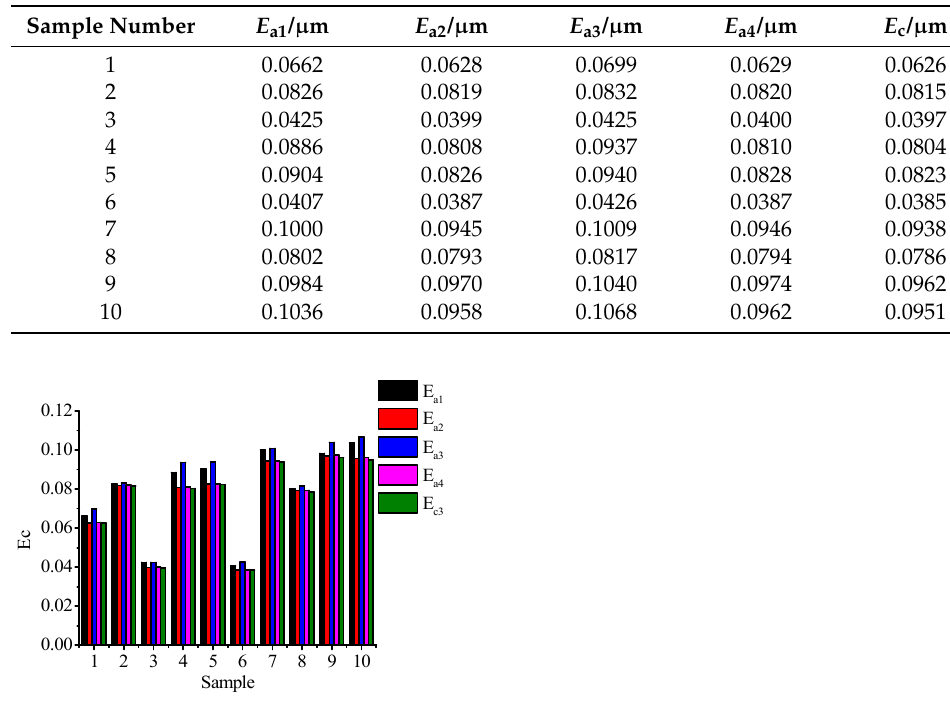
Figure 14. Comparison of calculation results of different methods.